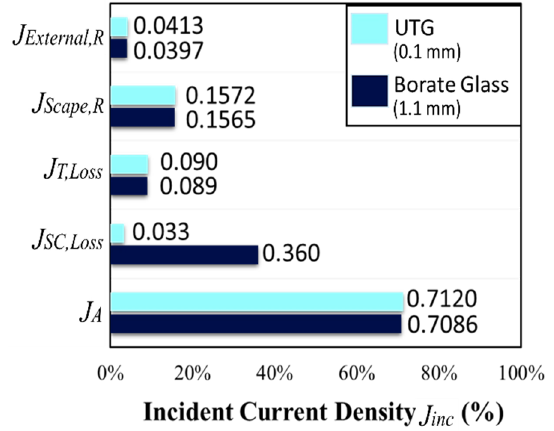
Figure 11. Thin film design with an optimum frontal layer using UTG/ITO/CdS/CdTe (2 µ m).